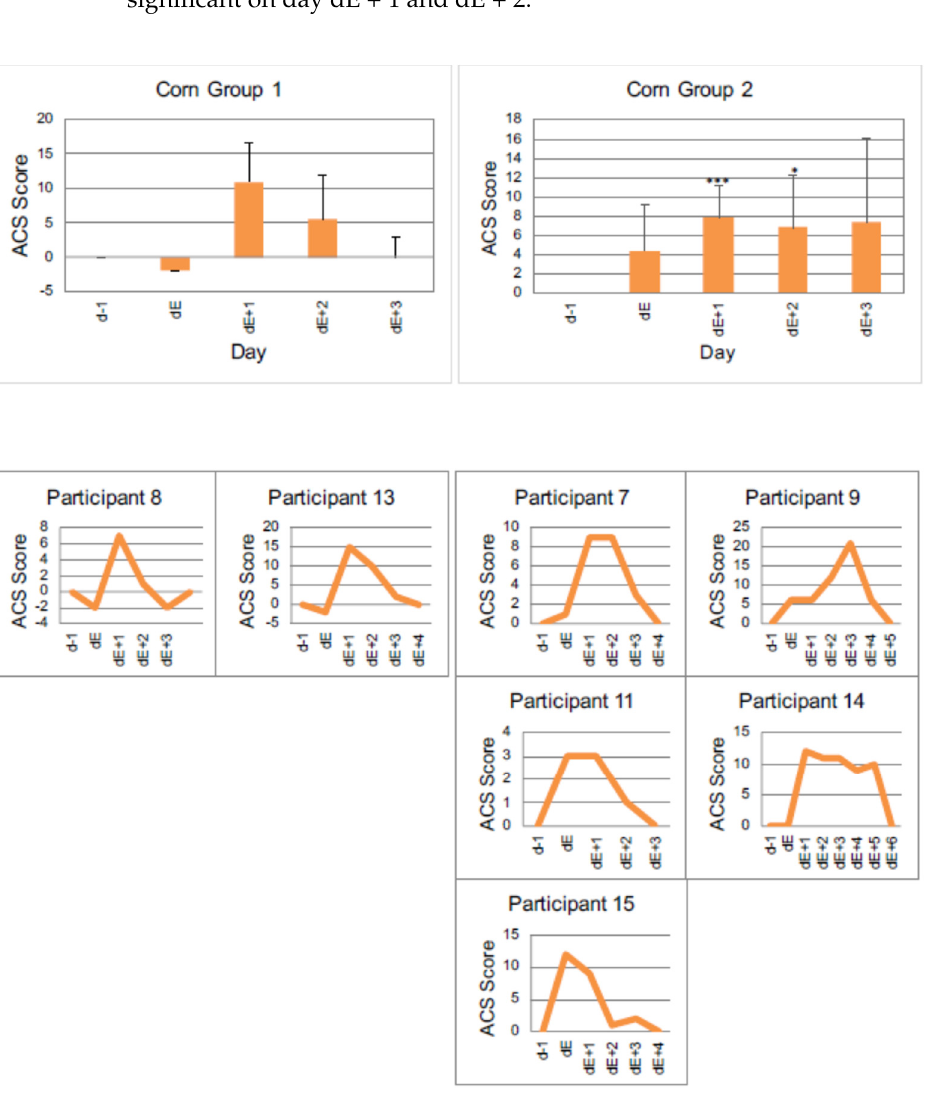
Figure 5. Individual reactions of participants to corn, measured by ACS. Group 1 (participants with a decrease of value in ACS on the day of reintroduction), vs. Group 2 (participants with an increase of value in ACS at the day of reintroduction) p < 0.05 *, p < 0.001 *** (one-sided t -test). dE − 1: day before reintroduction, dE: day of reintroduction, dE + 1: day 1 after reintroduction etc. Table 5. Means and standard deviations of intolerance reactions to corn of Group 1 ( n = 2).